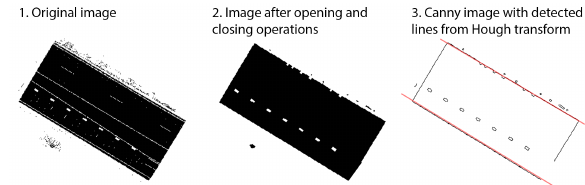
Figure 3. An overview of the pre-processing steps taken for the detection of the asphalt edges. (1) is the original 2D image obtained from the point cloud. (2) the result of a closing-opening operation. (3) the final input image for the Hough transform after applying the Canny operation overlapped with the detected Hough